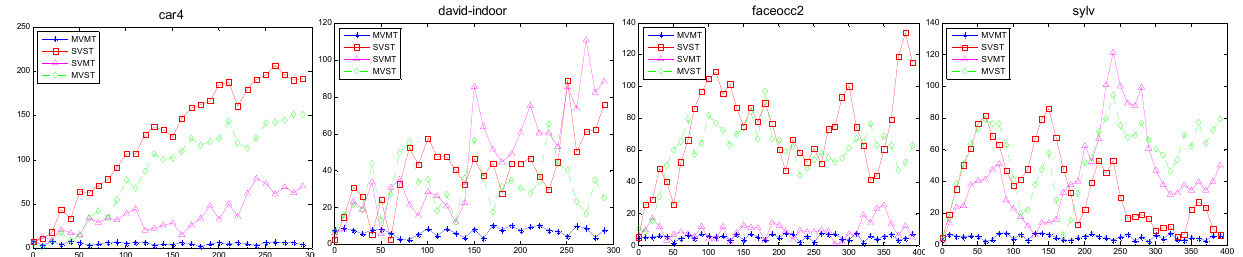
Figure 13. The errors of the proposed MVMT algorithm and SVST, MVST, SVMT algorithms (pixel).